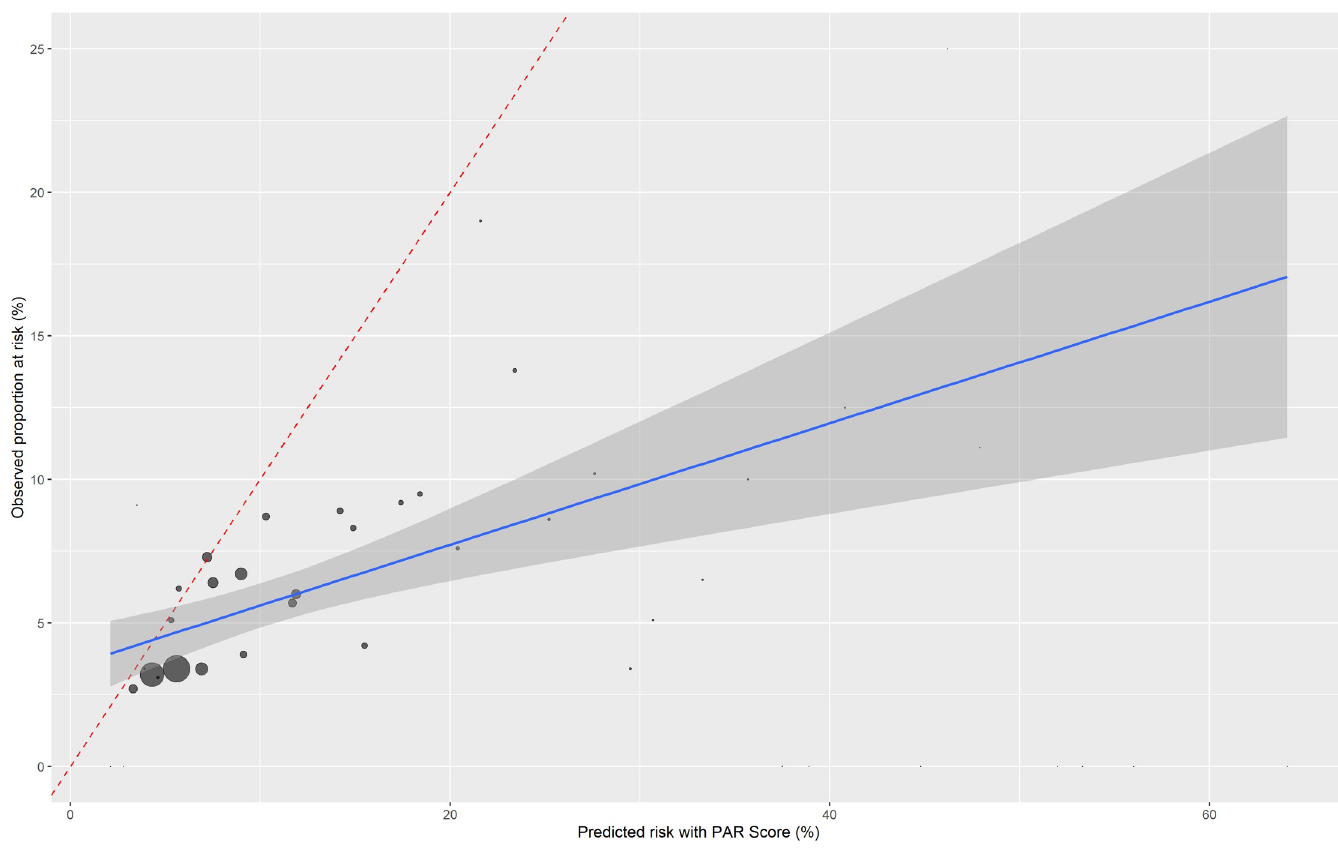
Fig 3. Calibration plot of the PAR Risk Score weighted by number of participants.